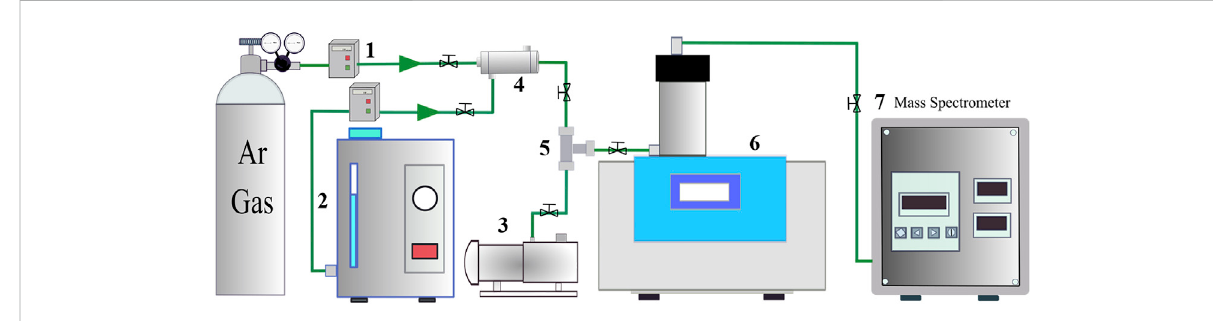
FIGURE 1 The experimental setup for the TG-DTA analyses. 1. Argon mass fl ow controller; 2. Hydrogen generator; 3. Vacuum pump; 4. Gas mixer; 5. Three-way valve; 6. TG-DTA; 7. Mass